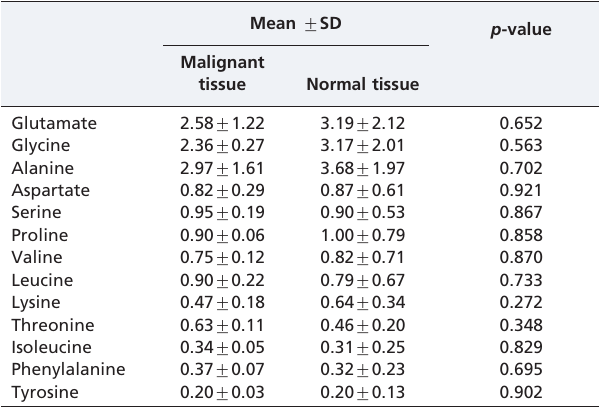
Table 2 - Amino acid content ( m mol/g) in malignant and normal tissues of patients with squamous cell carcinoma of the oral cavity.